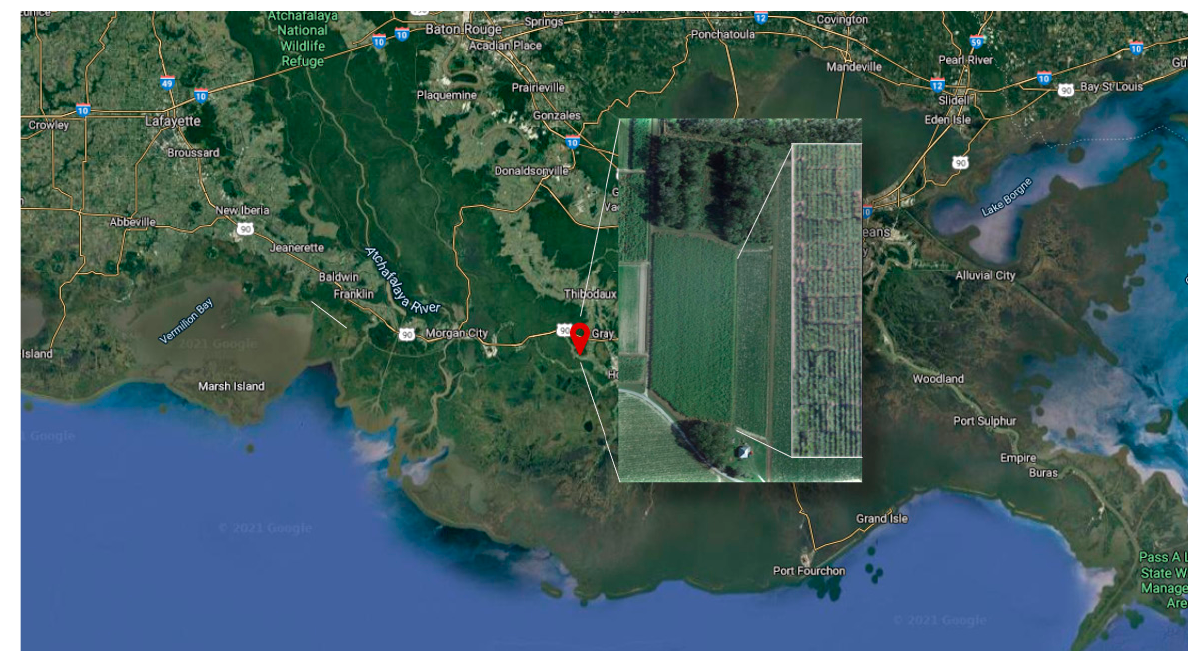
Figure 1. Satellite image of Louisiana with drone image of sugarcane seedling test plots taken near Houma, Louisiana USA in plant cane 2016, expanded. Table 1. Comparison of least square means of sugarcane seedlings cane plot weight. Plant Cane Second